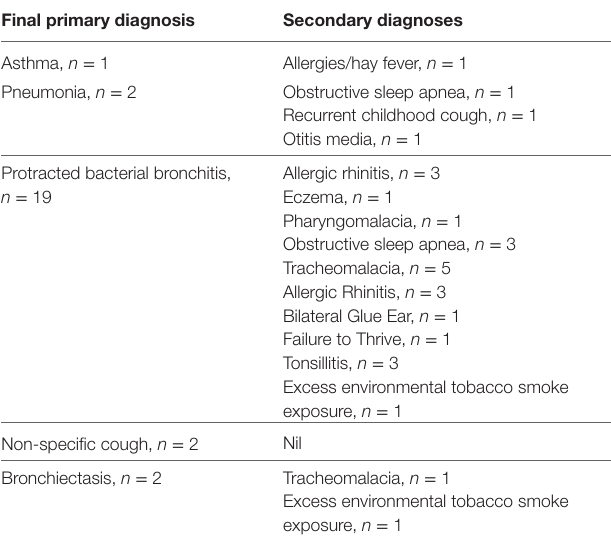
TaBle 5 | Final and secondary diagnoses of 26 children with chronic cough who presented for specialist review.